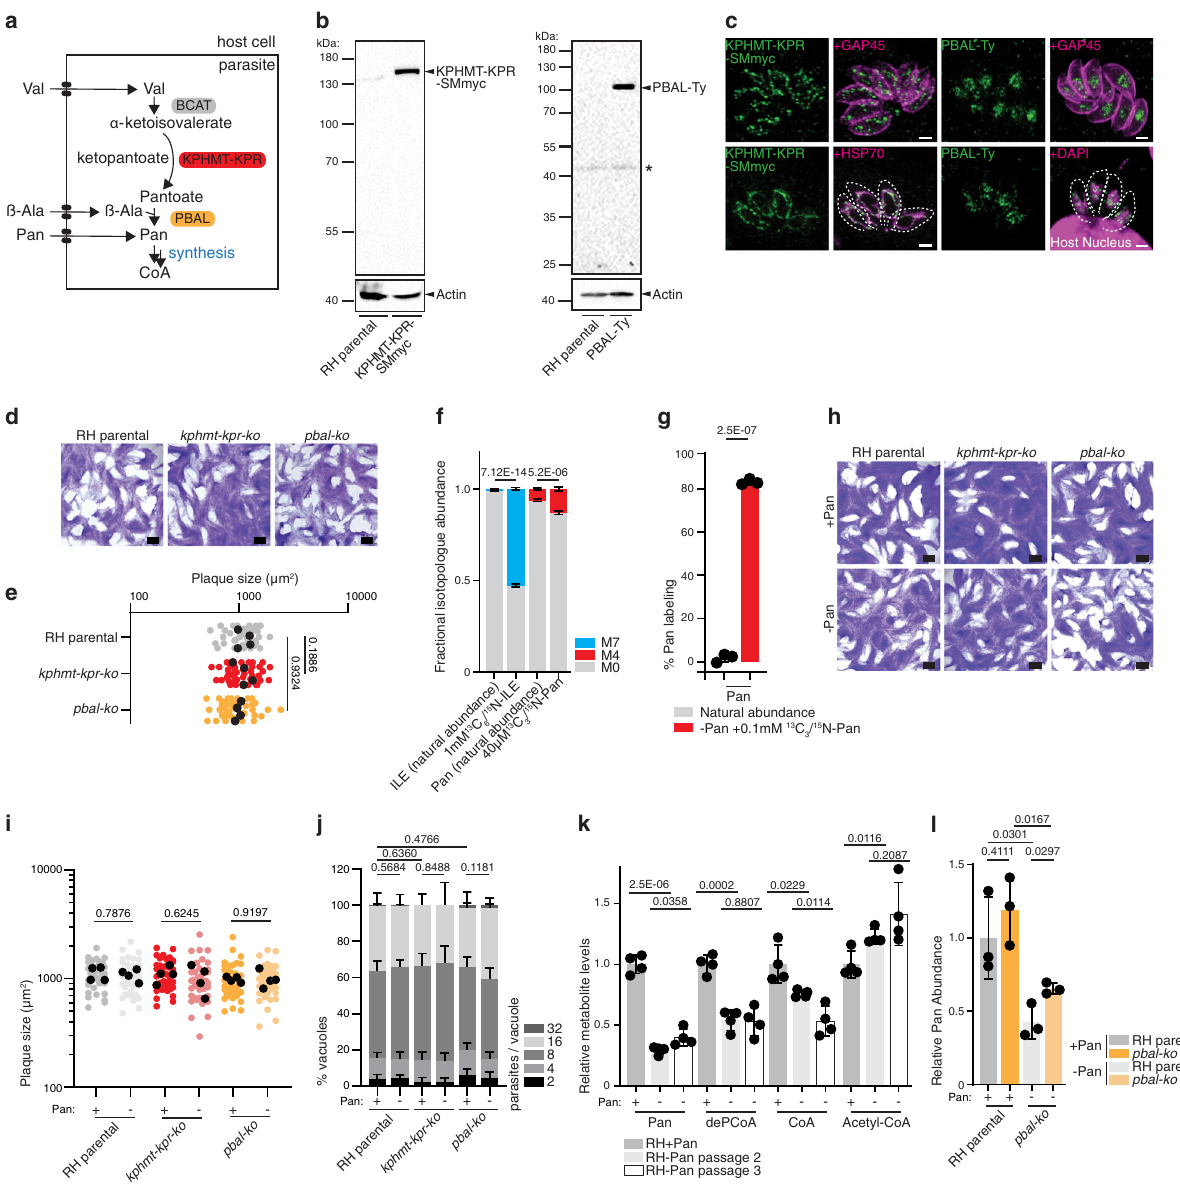
Fig. 5 The Pan synthesis pathway is dispensable due to Pan uptake in tachyzoites. a Scheme of the Pan biosynthesis pathway, highlighting the ketopantoate hydroxymethyltransferase - ketopantoate reductase (KPHMT-KPR) and the pantoate beta alanine ligase (PBAL). See Fig. 1 for abbreviations. b Western blots of endogenous C-terminally spaghetti-monster (SMmyc) tagged KPHMT-KPR (MW 144 KDa, n = 3) and endogenous C-terminally Ty tagged PBAL (MW 93 KDa, n = 3), respectively. Antibodies anti-myc and anti-Ty, anti actin as loading controls. c Immuno fl uorescence assay of KPHMT- KPR-SMmyc ( n = 3) and PBAL-Ty ( n = 5). Antibodies anti-myc and anti-Ty, anti GAP45 (pellicle), anti HSP70 (mitochondrion), DAPI (nucleus). d Plaque assay of RH parental, kphmt-kpr-ko ( n = 4) and pbal-ko ( n = 6). e Quanti fi cation of plaque size. Black dots present the average of each independent experiment. ( n = 4, 2-sided t -test). f LC-MS analysis of Pan (M0, M4) and isoleucine (M0, M7) isotopologues, following 15 min incubation of isolated RH parasites in medium + 40 μ M 13 C 3 / 15 N-Pan and 1 mM 13 C 6 / 15 N-isoleucine (ILE) ( n = 3 – 6, mean and SD, 2-sided Student ’ s t test). g GC-MS analysis of RH parental derived Pan upon culture in medium containing 13 C 3 / 15 N-Pan (100 μ M) for 40 h ( n = 4, mean and SD, 2-sided Student ’ s t test). h Plaque assay of mutant parasites in ±Pan culture medium ( n = 4). i Quanti fi cation of plaque size. Black dots present the average of each independent experiment. ( n = 4, 2-sided t -test). j Intracellular growth assay of mutant parasites in ±Pan culture medium ( n = 3 – 6, mean and SD, 2 tailed t -test on the “ 16 parasites/vacuole ” category). k LC-MS measurement of intracellular Pan, dephospho-CoA (deP-CoA), coenzyme A (CoA) and acetyl-CoA (AcCoA) in RH parental parasites grown for 2 and 3 passages (P2, P3) in ±Pan culture media. Metabolite levels normalized to internal standard ( 13 C 3 / 15 N-Pan) and quanti fi ed relative to RH + Pan ( n = 4, mean and SD, 2-sided Student ’ s t test). l GC-MS measurement of Pan levels in RH parental and pbal-ko parasites grown in ±Pan culture medium. Metabolite levels normalized to signal intensity of the total ion chromatogram and quanti fi ed relative to RH + Pan. ( n = 4, mean and SD, 2-sided Student ’ s t test). n number of independent biological replicates. Source data are provided as a Source Data fi le. White scale bar 2 µ m, black scale bar 1 mm. Asterisks mark unspeci fi c